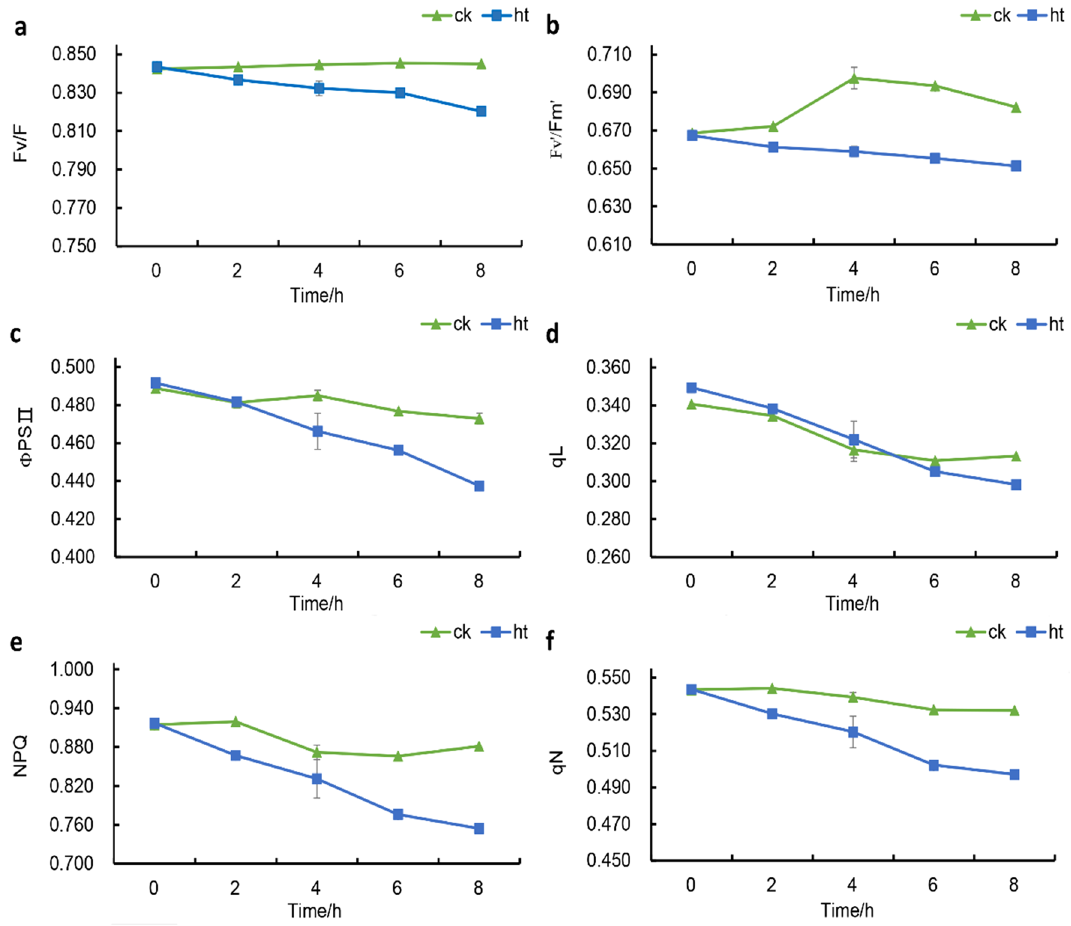
Figure 1. Effects of heat stress on the ( a ) Fv/Fm, ( b ) Fv`/Fm`, ( c ) ΦPSII, ( d ) qL, ( e ) NPQ and ( f ) qN of PS IIphotochemistry (significant difference at 5% levels according to standard deviation and multiple